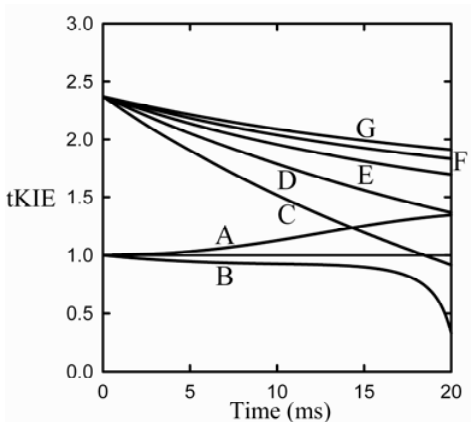
Figure 3. Application of the first rule to an assumed reaction mechanism. This example assumes an intrinsic KIE = 2.3, and that the iss is step 2